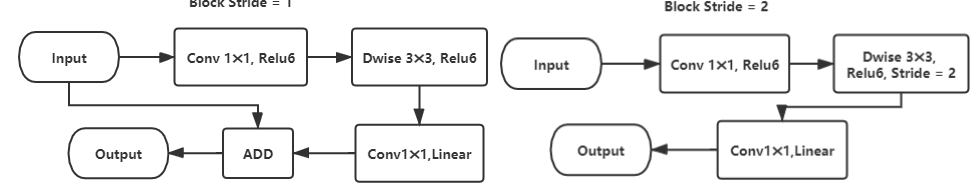
Figure 6. Linear bottlenecks and inverted residuals.